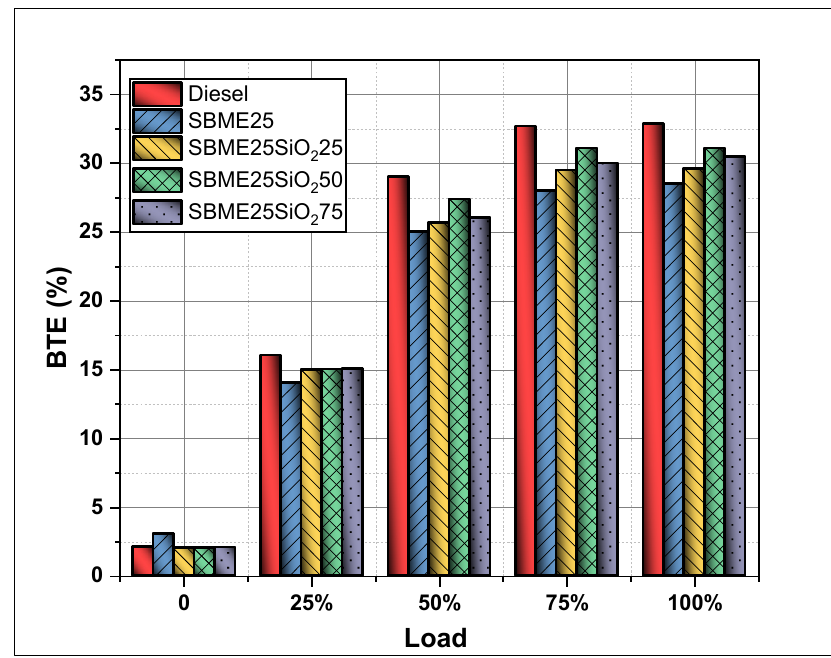
Figure 8. Effect of SiO 2 nano-additives on BTE at varying load.